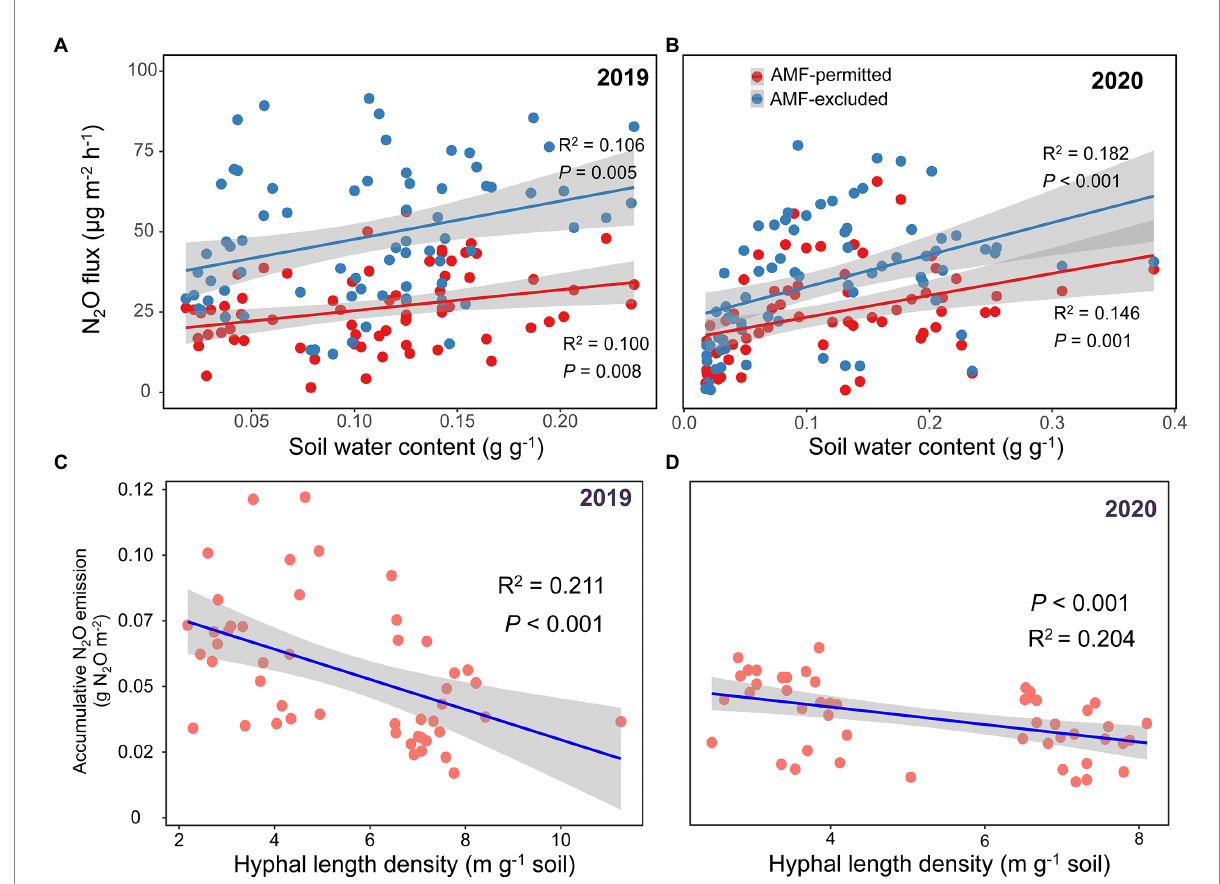
FIGURE 3 Relationships between soil water content (SWC) and N 2 O flux across growing seasons in both 2019 (A) and 2020 (B) . Relationships between hyphal length density and accumulative N 2 O emission across growing seasons both 2019 (C) and 2020 (D) . The fitted lines are from the OLS regression. Shaded areas show a 95% confidence interval of the